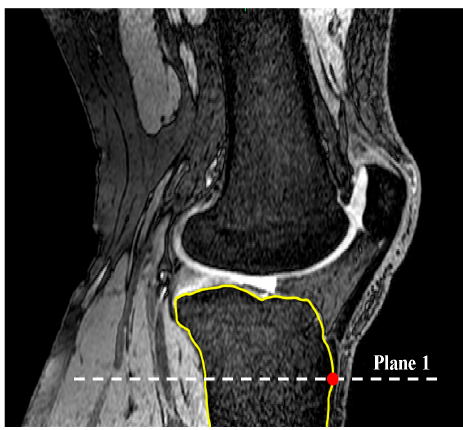
Figure 1. Identification of the most anterior point on the tibia in the sagittal plane to define plane 1 (Sagittal view).